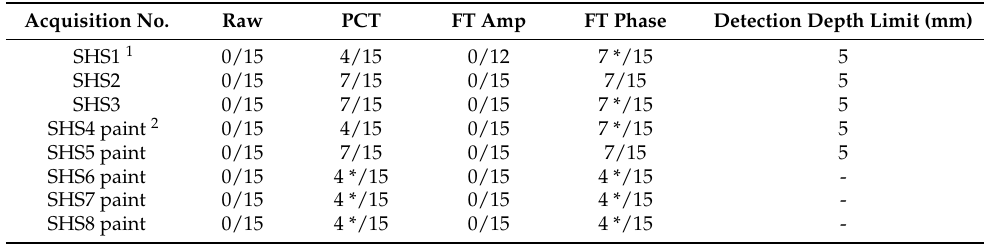
Table 13. Step-heating results from the inspection of the CF-PET-CF sandwich sample.